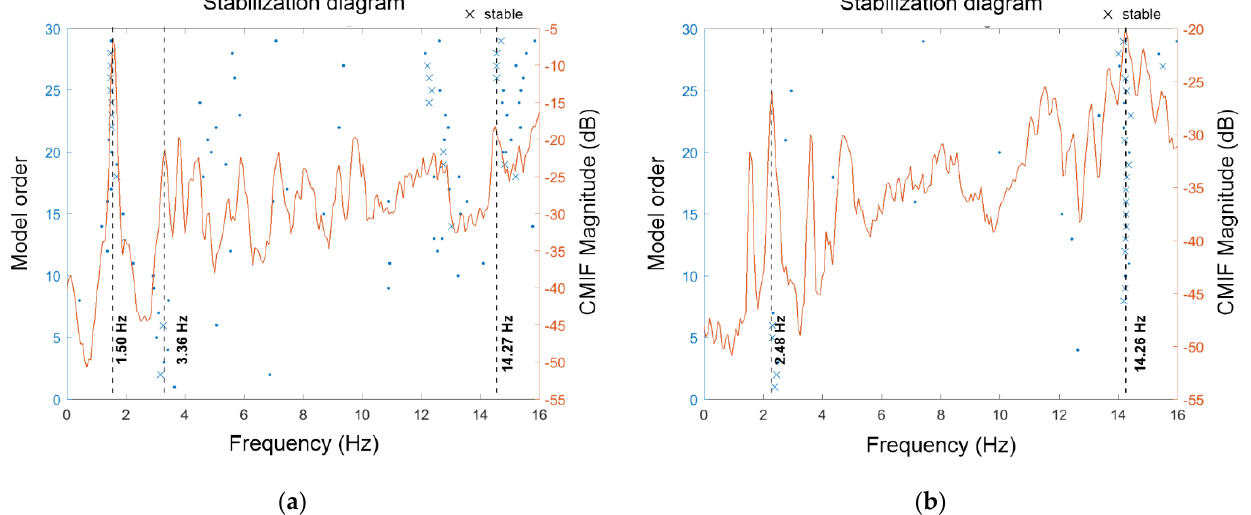
Table 2. Comparison of experimentally measured and preliminary calculated natural frequencies and description of mode shapes.